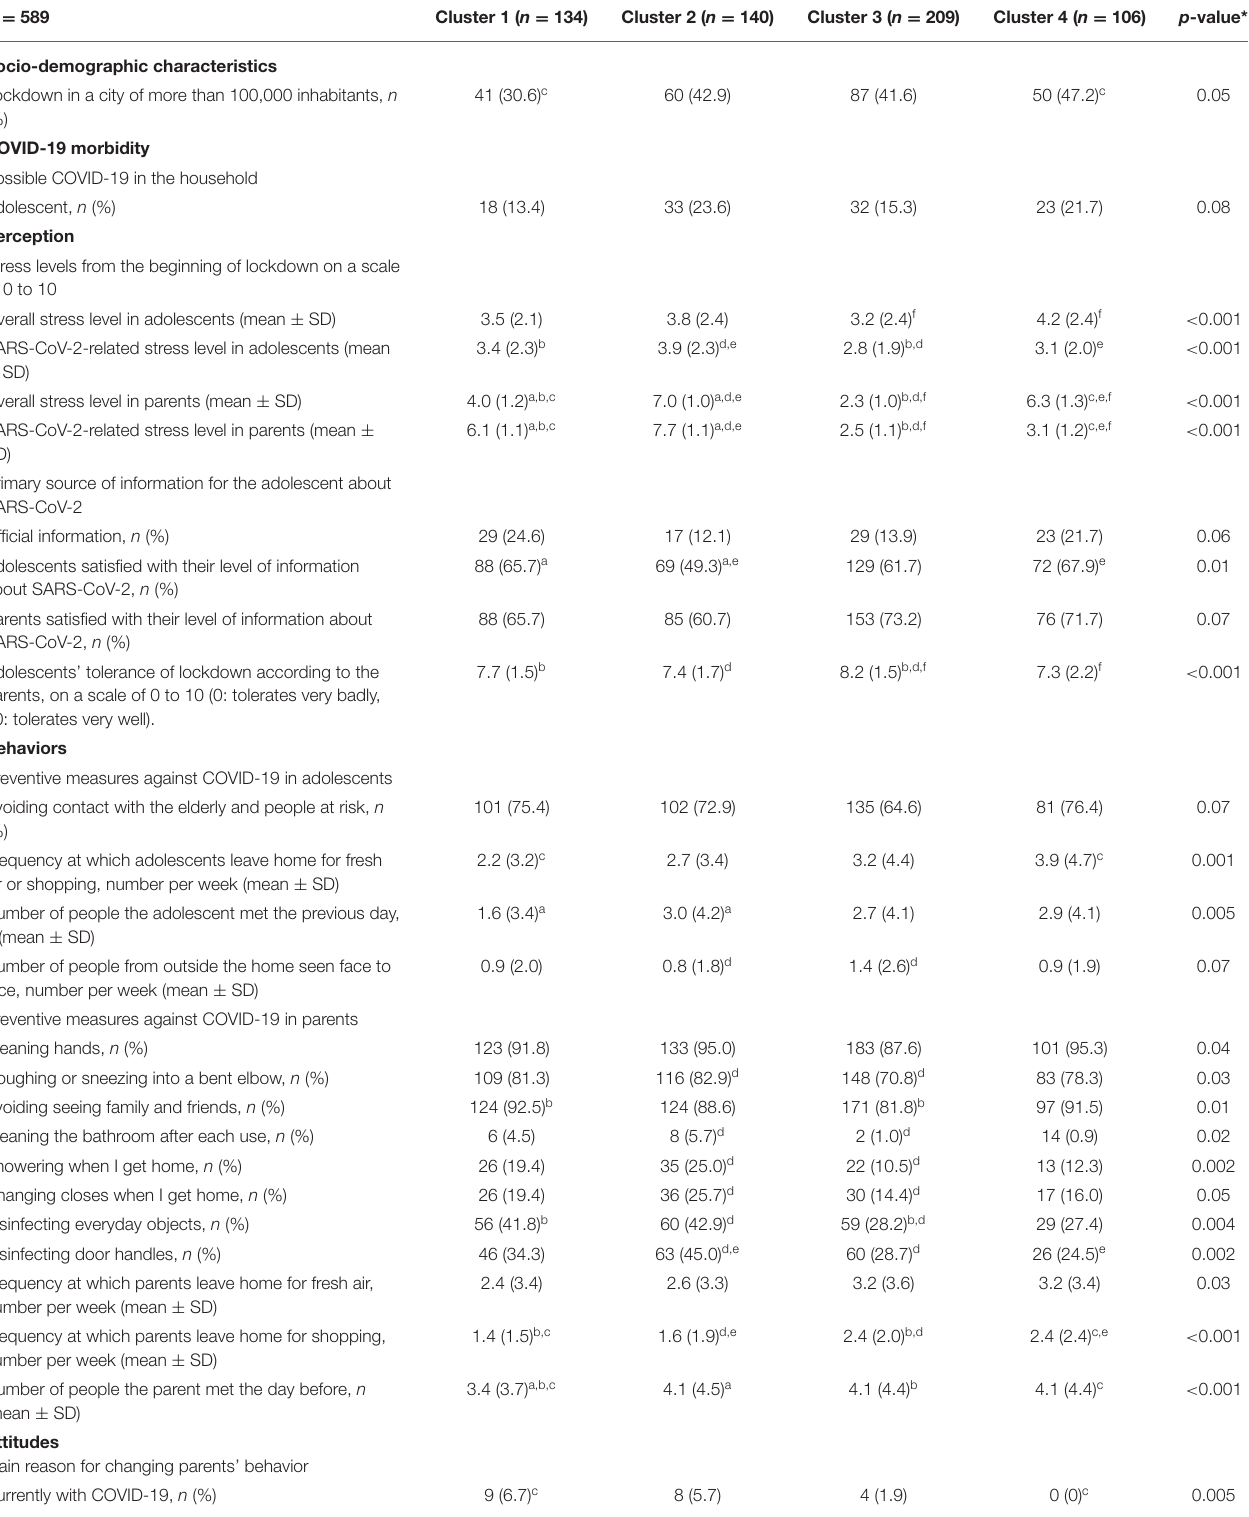
TABLE 4 | Profiles of families from the PARIS birth cohort based on socio-demographic characteristics, COVID-19 morbidity, perception, behaviors, and attitudes during the lockdown. N =